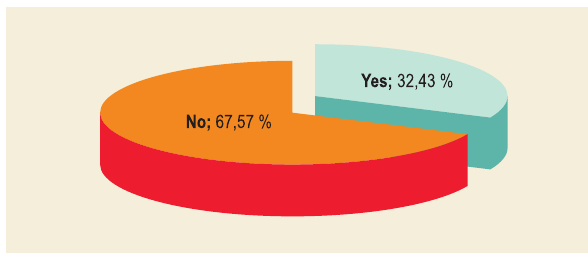
Fig. 3. The concept of a learning organization whish has been started to actualize in the organization